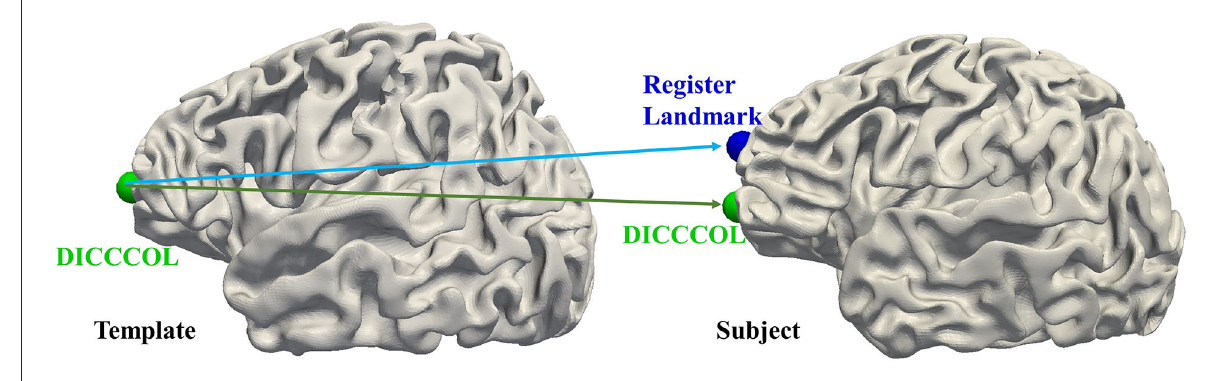
FIGURE8 Illustration of functional consistency between DICCCOL landmark and registered landmark.